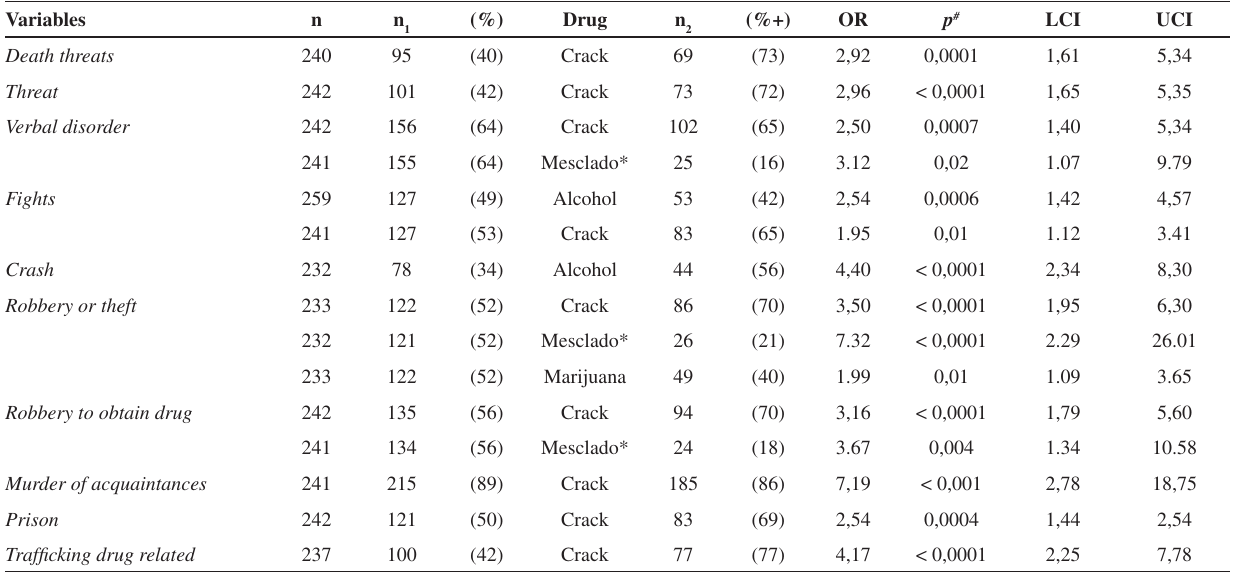
Table 4 - Drug and violence associations observed in a sub-sample of individuals (259) who reported violence linked to drug use Variables n